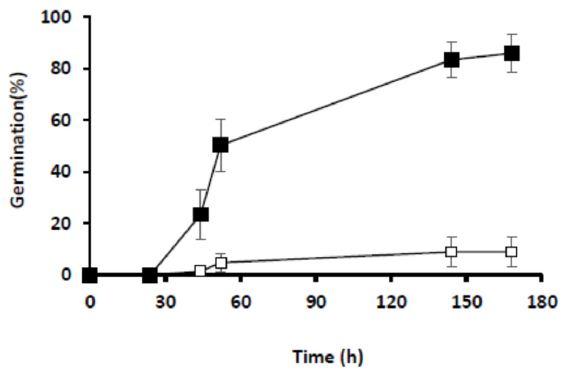
Figure 1. Germination of freshly-harvested Arabidopsis Col-0 seeds imbibed in darkness (open squares) or under continuous light (closed squares). Germination was scored at the indicated time. Values represent the mean S.E of three independent seed batches (150 seeds per batch).